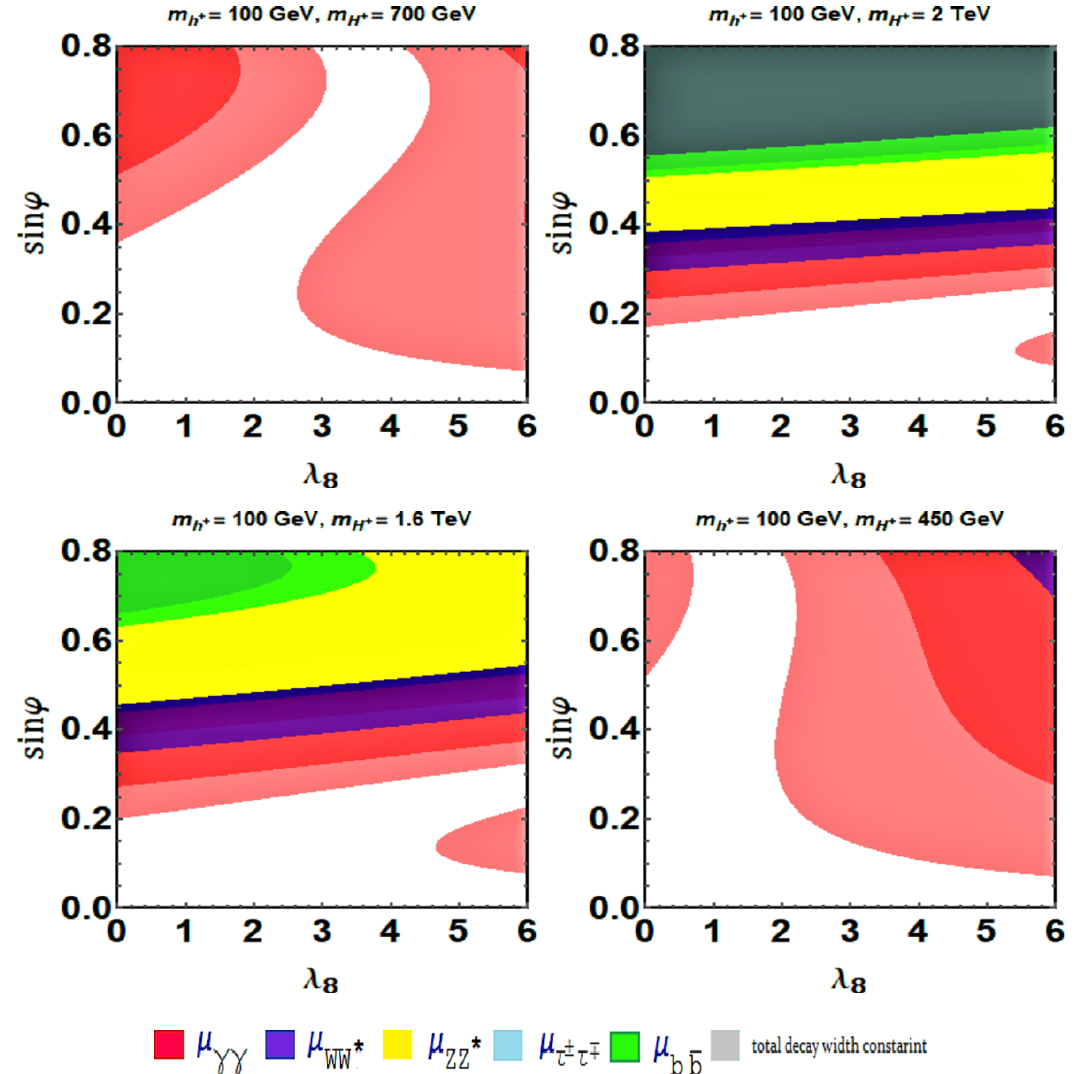
Figure 15 . Constraints from the Higgs boson properties in (cid:21) 8 (with (cid:21) 3 = (cid:21) 8 ). The red, cyan, green, yellow, and purple-shaded regions are excluded by the signal strength limits for various decay modes ( (cid:13)(cid:13); (cid:28)(cid:28); b (cid:22) b; ZZ ? ; WW ? ) respectively. The white unshaded region simultaneously satis(cid:12)es all the experimental constraints. Grey-shaded region (only visible in the upper right panel) is excluded by total decay width